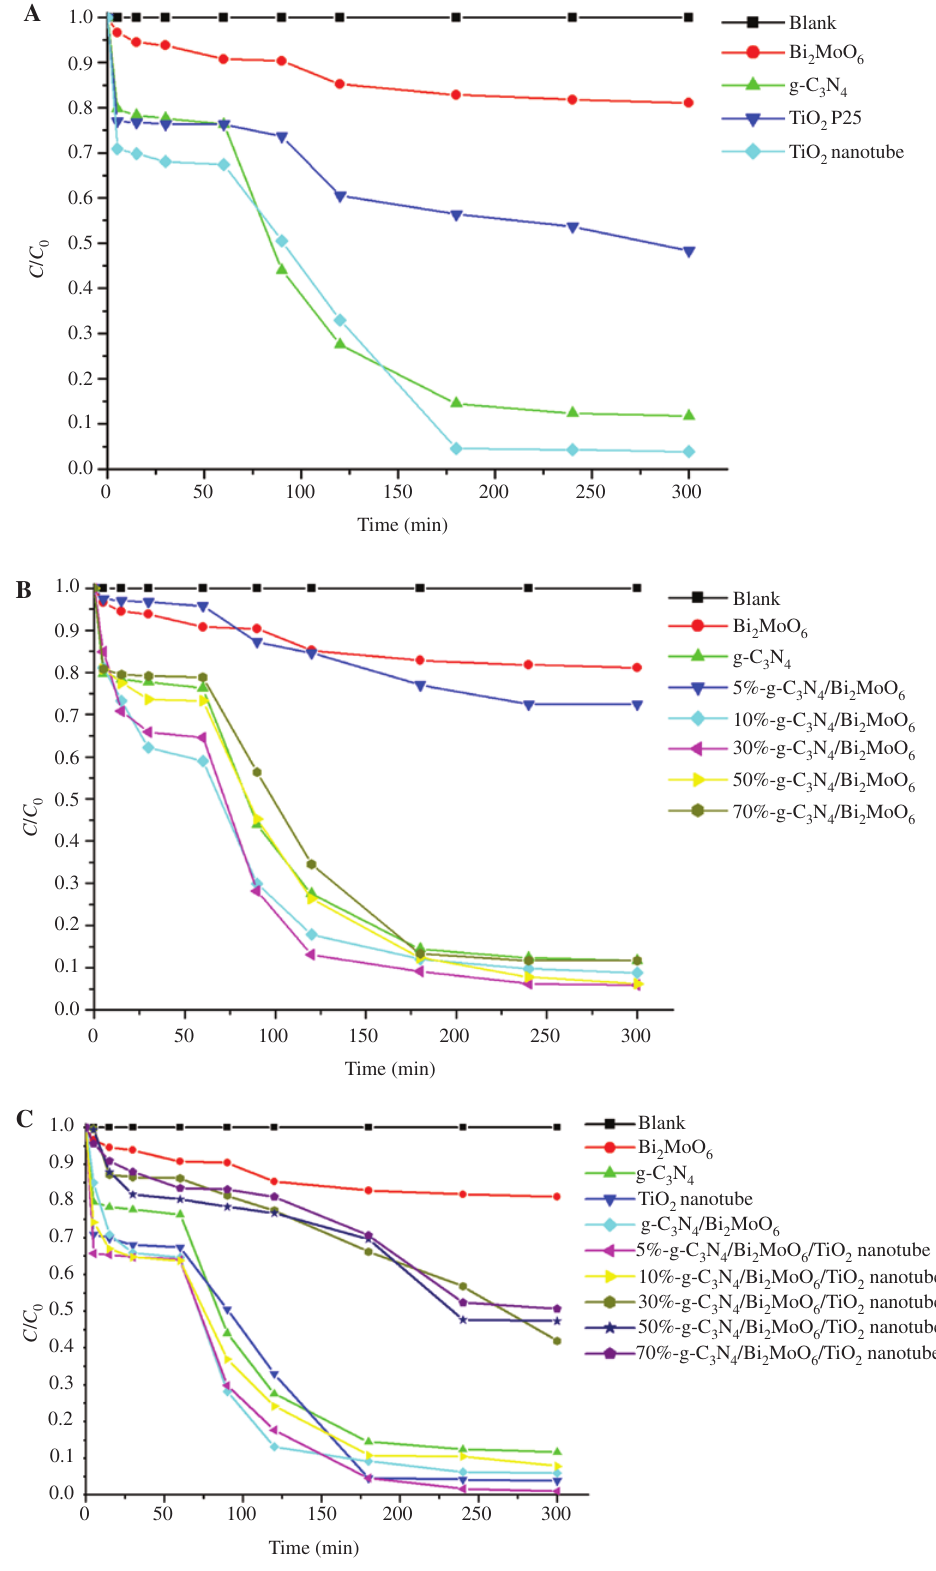
Figure 7: Photocatalytic decolorization of reactive black 5 caused by (A) unitary, (B) binary composite, and (C) ternary composite photocatalysts under visible light